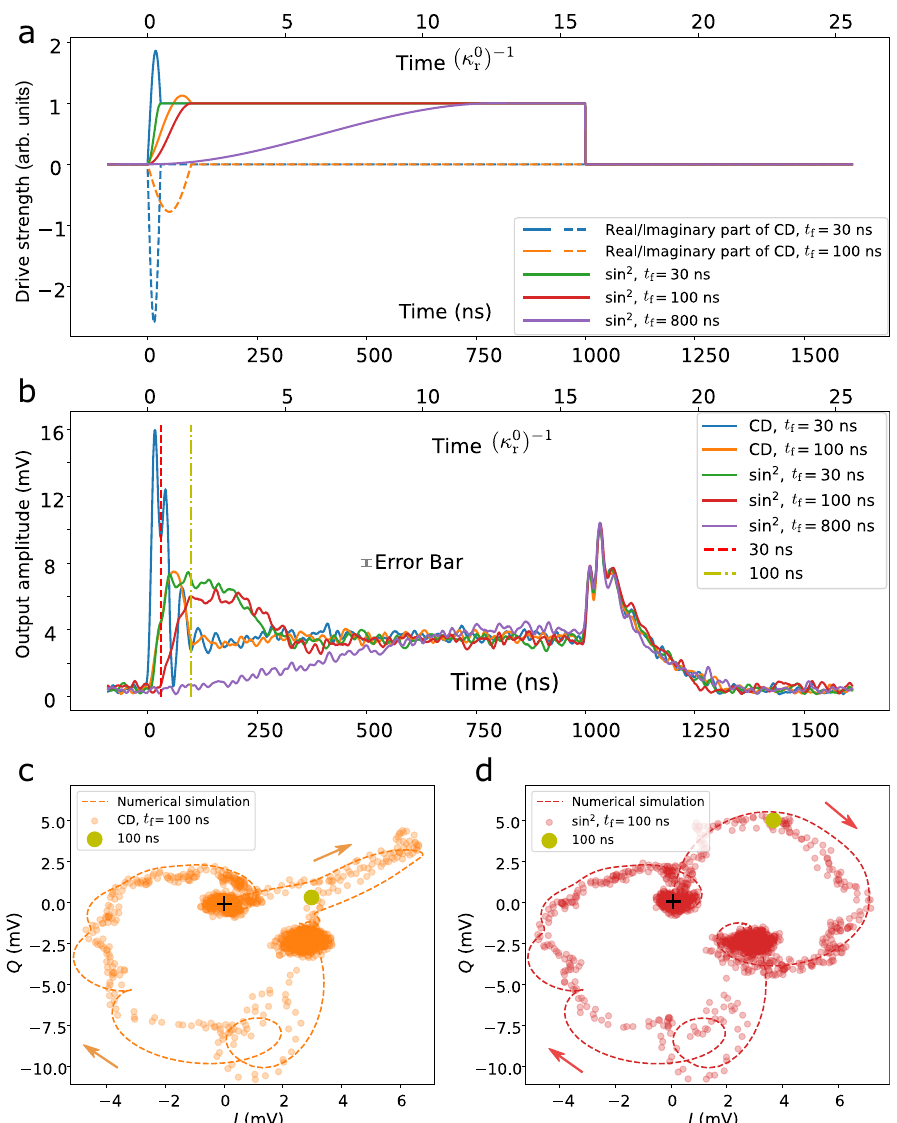
Fig. 2 Open system shortcut to adiabaticity by counterdiabatic (CD) driving and bare drivings. a Different pulses used in the experiment. The sin 2 ringups with fi nal time t f = 30 ns (green) and 100 ns (red) are used, along with their corresponding CD drivings (blue and orange). The drivings are kept constant at ϵ 0 after t f . A slow varying sin 2 driving with t f = 800 ns (purple) is used to illustrate the adiabatic ringup timescale. b Output amplitude (in mV) measured by room-temperature FPGA. End times of the CD driving protocols are marked for t f = 30 ns (red) and 100 ns (yellow). The non-equilibrium excitation after t f = 30 ns is caused by excitation of the Purcell fi lter mode due to the relatively small resonator- fi lter detuning. The error bar is the standard deviation of the points in the equilibrium states at 990 ns. c , d We decompose the output signal into its (I)n-phase and (Q)uadrature components, and plot the corresponding IQ trajectories for the t f = 100 ns sin 2 driving ( d ) and its CD driving ( c ). Trajectories begin at the points indicated by black crosses. Arrows alongside the simulation indicate the direction of the time evolution. The simulated trajectories are calculated based on the input-output formalism detailed in Supplementary Note 1. To avoid the dif fi culty of direct tomography, we can infer the bosonic system mean- fi eld state from the output signal. The good fi t between simulation and experiment data suggests that the CD driving does indeed realise adiabatic following. The mismatch mainly comes from the weak nonlinearity of the resonator. All experimental points are averaged over 3 × 10 4 experiments. A Savitzky-Golay fi lter with window length 21 and polynomial order 3 is applied to improve the signal-noise